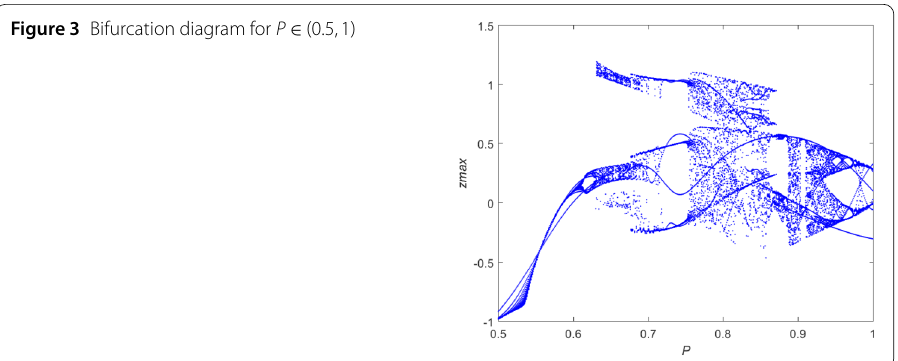
Figure 3 Bifurcation diagram for P ∈